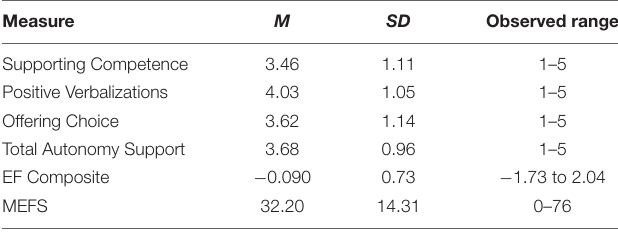
TABLE 1 | Means, standard deviations, and ranges for autonomy support and child EF measures.